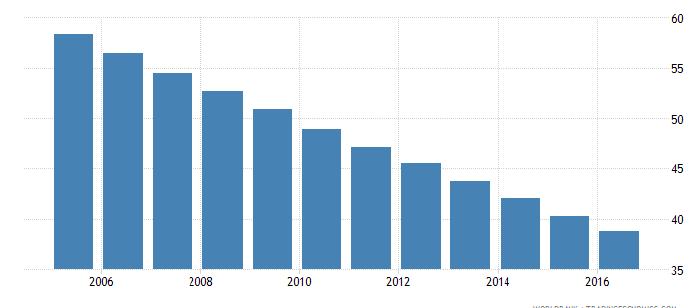
Figure 2: Average infant mortality in Asian countries (per 1000